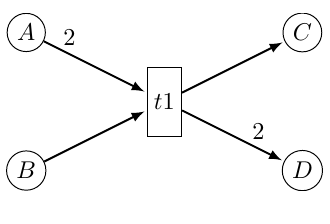
Figure 5: A Petri net